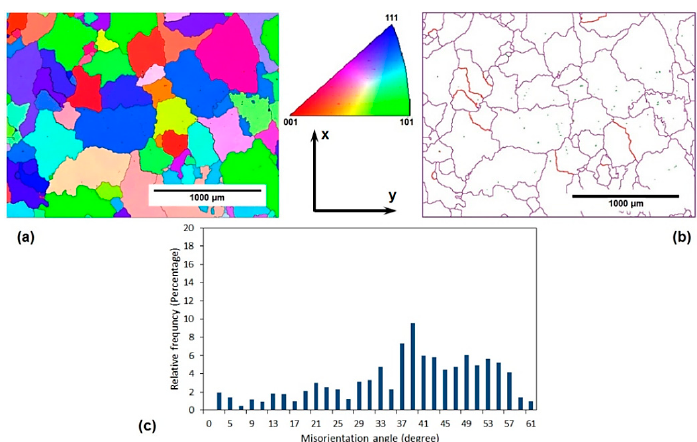
Figure 2. Microstructure features of initial annealed AA ‐ 6063 alloy before MFD process: ( a ) the electron back scatter diffraction (EBSD) grain orientation map, ( b ) the EBSD grain boundary map, and ( c ) the misorientation angle distribution diagram.